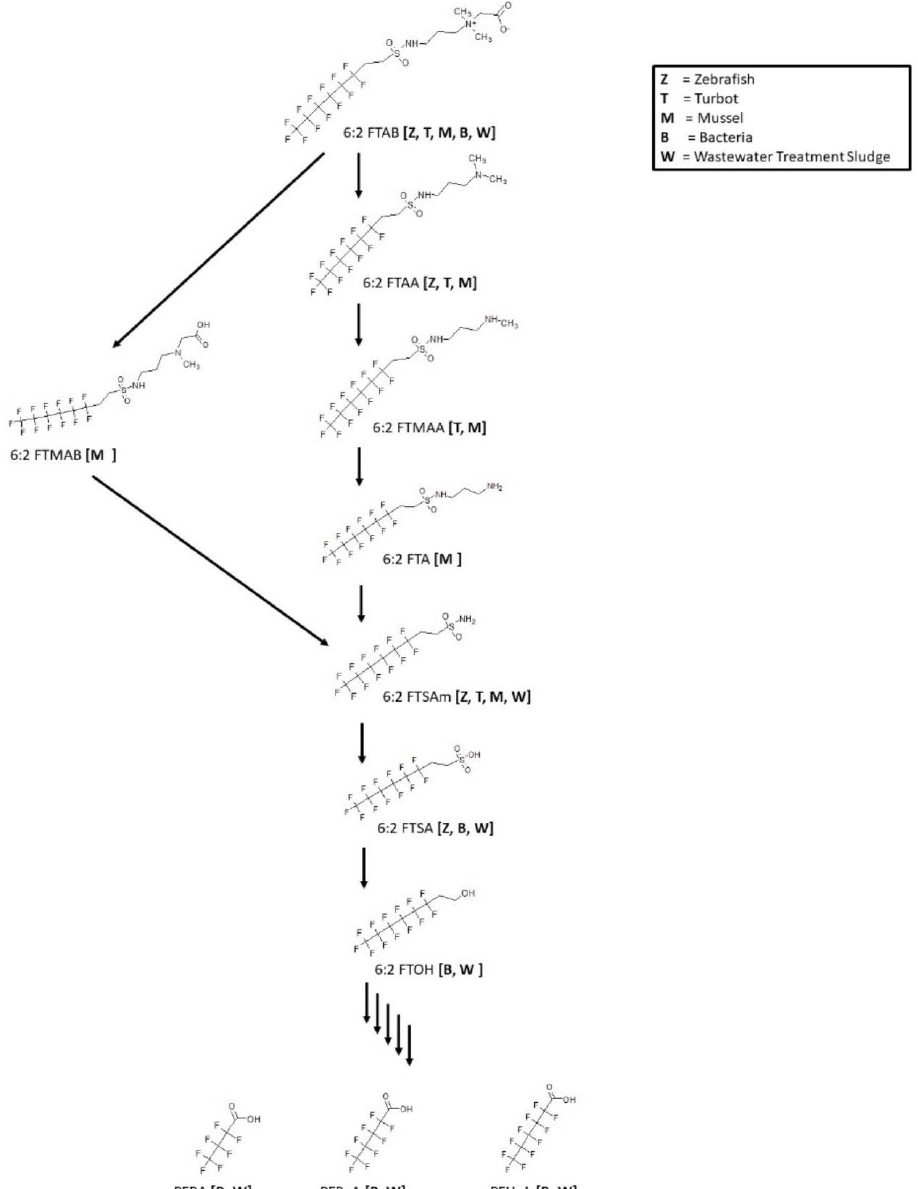
Figure 15. Metabolic map for 6:2 fluorotelomer sulfonamide alkylbetaine (6:2 FTAB) as found in zebrafish [64], turbot [65], mussel [65], bacteria [66] and wastewater treatment sludge [67].